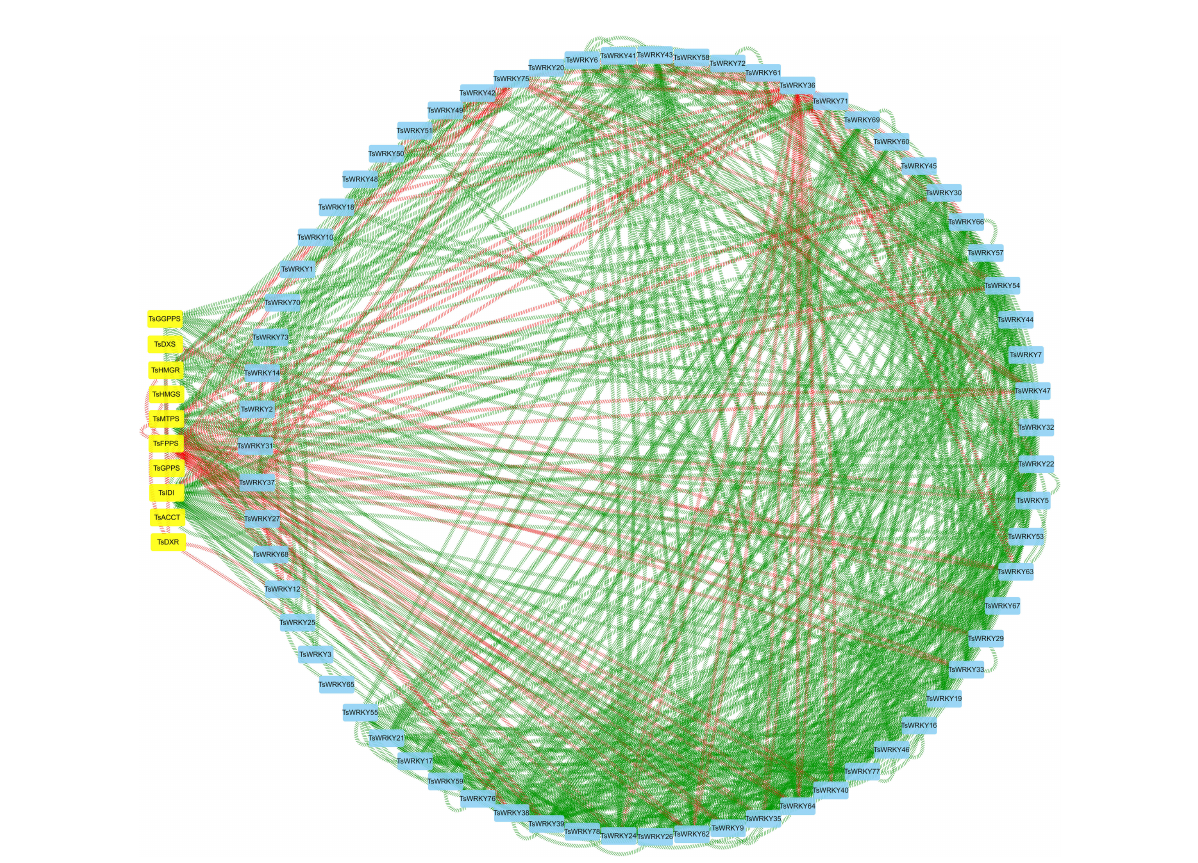
FIGURE 10 Correlation analysis of TsWRKYs and terpenoid synthesis genes (Pearson correlation coef fi cient > 0.95). The square nodes colored in blue are TsWRKYs , the square nodes colored in yellow are terpenoid synthesis genes, the green line represents positive correlation, and the red line represents negative